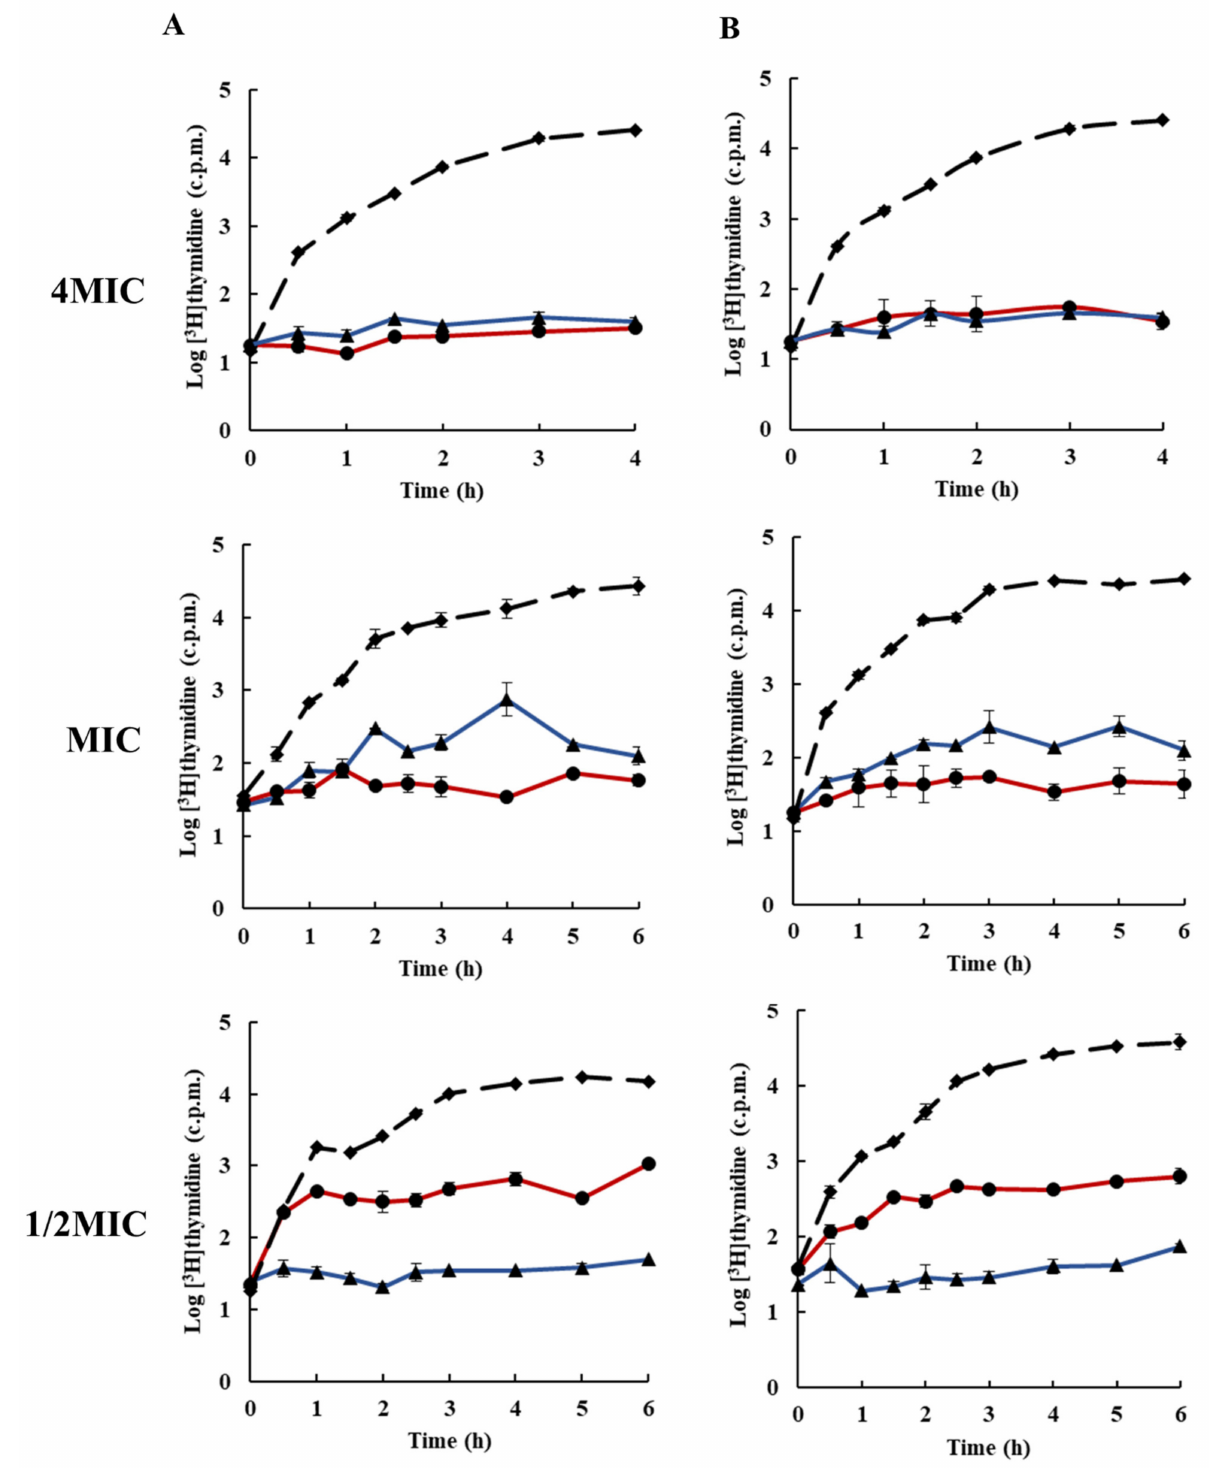
Figure 2. Effects of rhodomyrtone on DNA synthesis at 4 × MIC, MIC, and 1/2 × MIC on ( A ) EMRSA-16, ( B ) S. aureus Figure 5. Effects of rhodomyrtone on cell wall synthesis at 4× MIC, MIC, and 1/2× MIC on ( A ) EMRSA-16 and ( B ) S. aureus ATCC 29213. DNA synthesis was determined by incorporation of [ 3 H]thymidine, rhodomyrtone (blue (cid:78) ), ELB21 (red • ), ATCC 29213. Cell wall synthesis was determined by incorporation of N-acetyl-d-[1- 3 H]glucosamine. rhodomyrtone (blue ▲ ), vancomycin and 1% DMSO (broken line (red ● ), and 1% DMSO (broken line  ). Each symbol indicates the mean ± SD for duplicates. ). Each symbol indicates the mean ± SD for